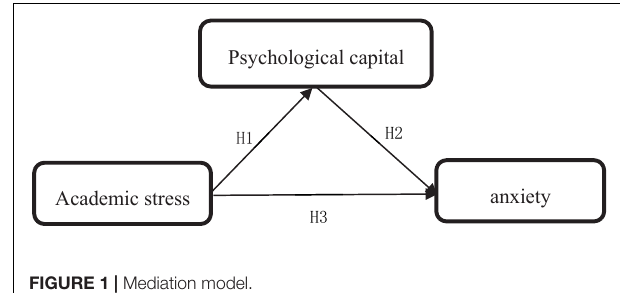
FIGURE 1 | Mediation model.